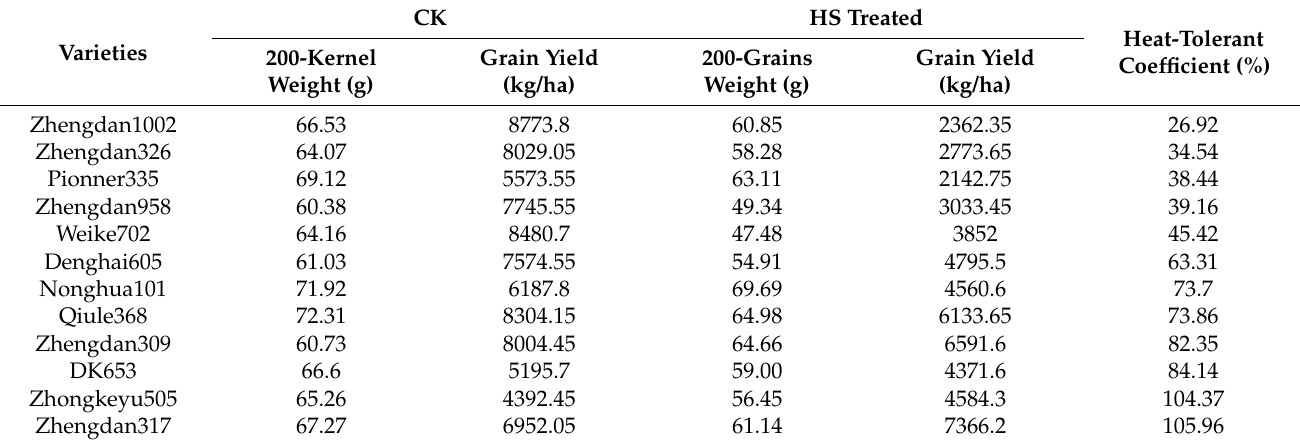
Table 1. Identification of the effects of heat stress on grain yield in 12 commercial